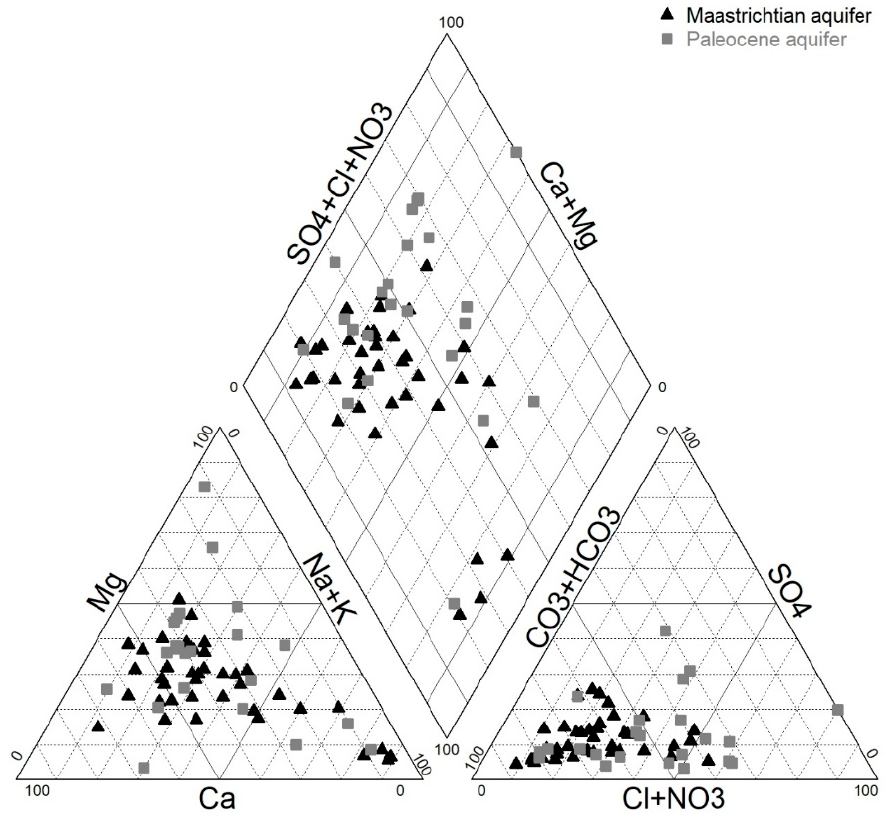
Figure 4. Piper diagram of the Paleocene and Maastrichtian aquifers.